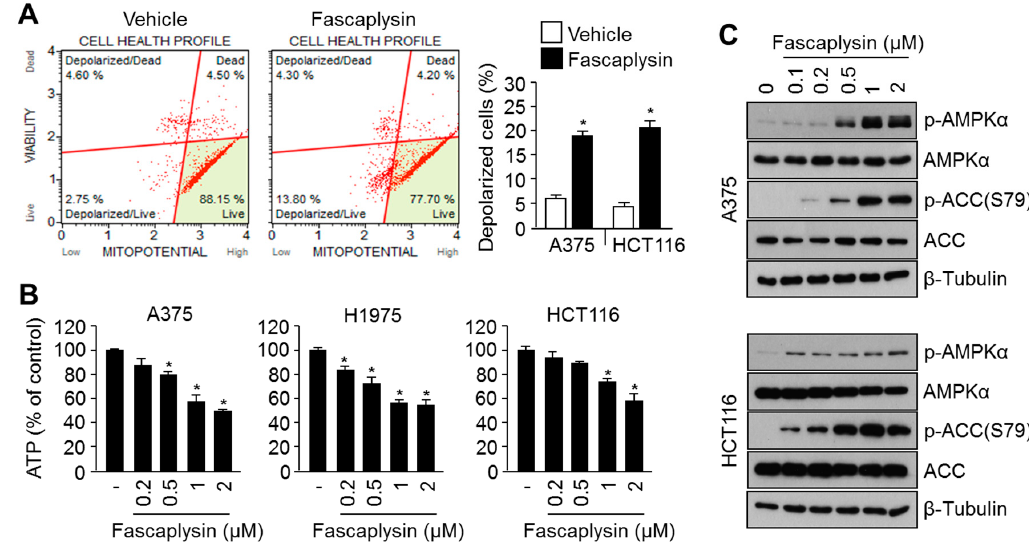
Figure 3. Fascaplysin causes mitochondrial depolarization and ATP depletion, resulting in increased AMPK phosphorylation and activation. ( A ) A375 and HCT116 cells were incubated with 1 μ M of fascaplysin or DMSO control for 8 h, and then cells were used to analyze mitochondrial depolarization. Mitochondrial potential was measured using a Muse™ Mitopotential assay kit and a Mini Flow Cytometry Muse™ Cell Analyzer, as described in Methods and Materials. Values are represented as the mean ± standard deviation (SD) of two independent experiments performed in triplicate; * p < 0.05. ( B ) A375, H1975, and HCT116 cells were cultured with various concentrations of fascaplysin or DMSO control for 8 h, and then cellular ATP levels were measured using an ATP assay kit as described in Methods and Materials. Relative ATP levels were normalized using total protein concentrations and compared to that of the DMSO control. Values are represented as the mean ± standard deviation (SD) of two independent experiments performed in triplicate; * p < 0.05. ( C ) A375 or HCT116 cells were treated with the indicated concentrations of fascaplysin or DMSO for 8 h, and then protein levels were measured by Western blotting.